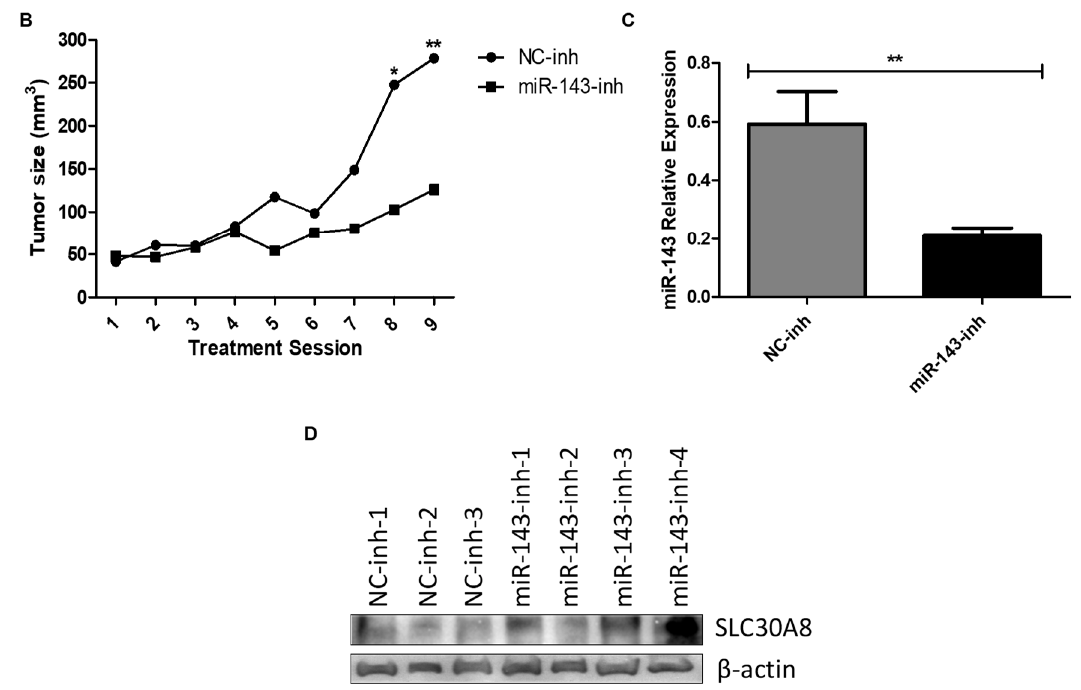
Figure 5. In vivo targeting of miR-143 reduces tumor growth. ( A ) Experimental design. ( B ) MiR-143 inhibition effect on tumor growth was calculated as described in the “Materials and Methods” section. ( C ) MiR-143 expression levels were measured by qPCR from total RNA extracted from mouse tumor tissues. Columns represent the means of N = 7 for NC-inh and N = 9 for miR-143-inh treatments ± SEM. ( D ) SLC30A8 expression levels were measured by western blot analysis in protein samples extracted from the mouse tumor tissues. * p < 0.05, ** p < 0.01.